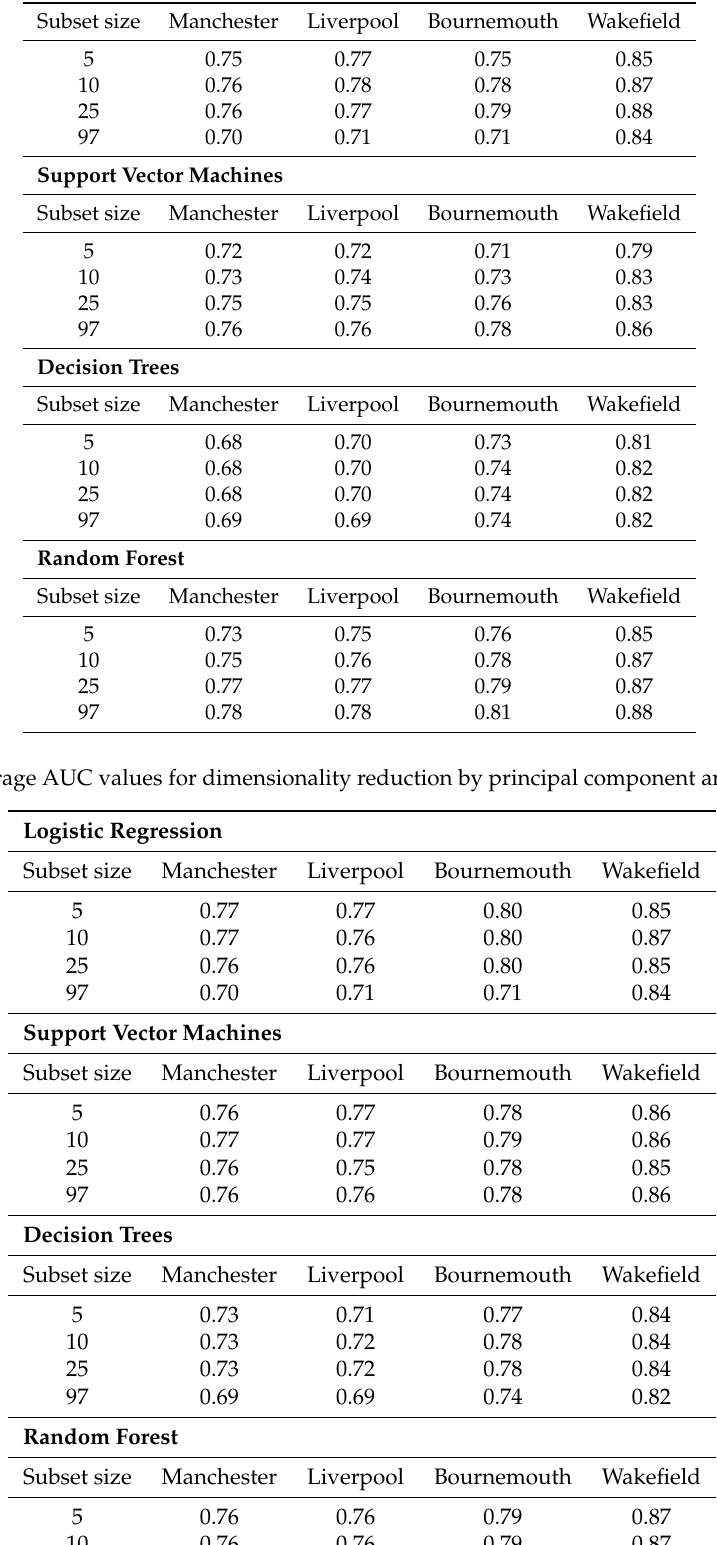
Table 4. Average AUC values for dimensionality reduction by attribute selection. Logistic Regression Subset size